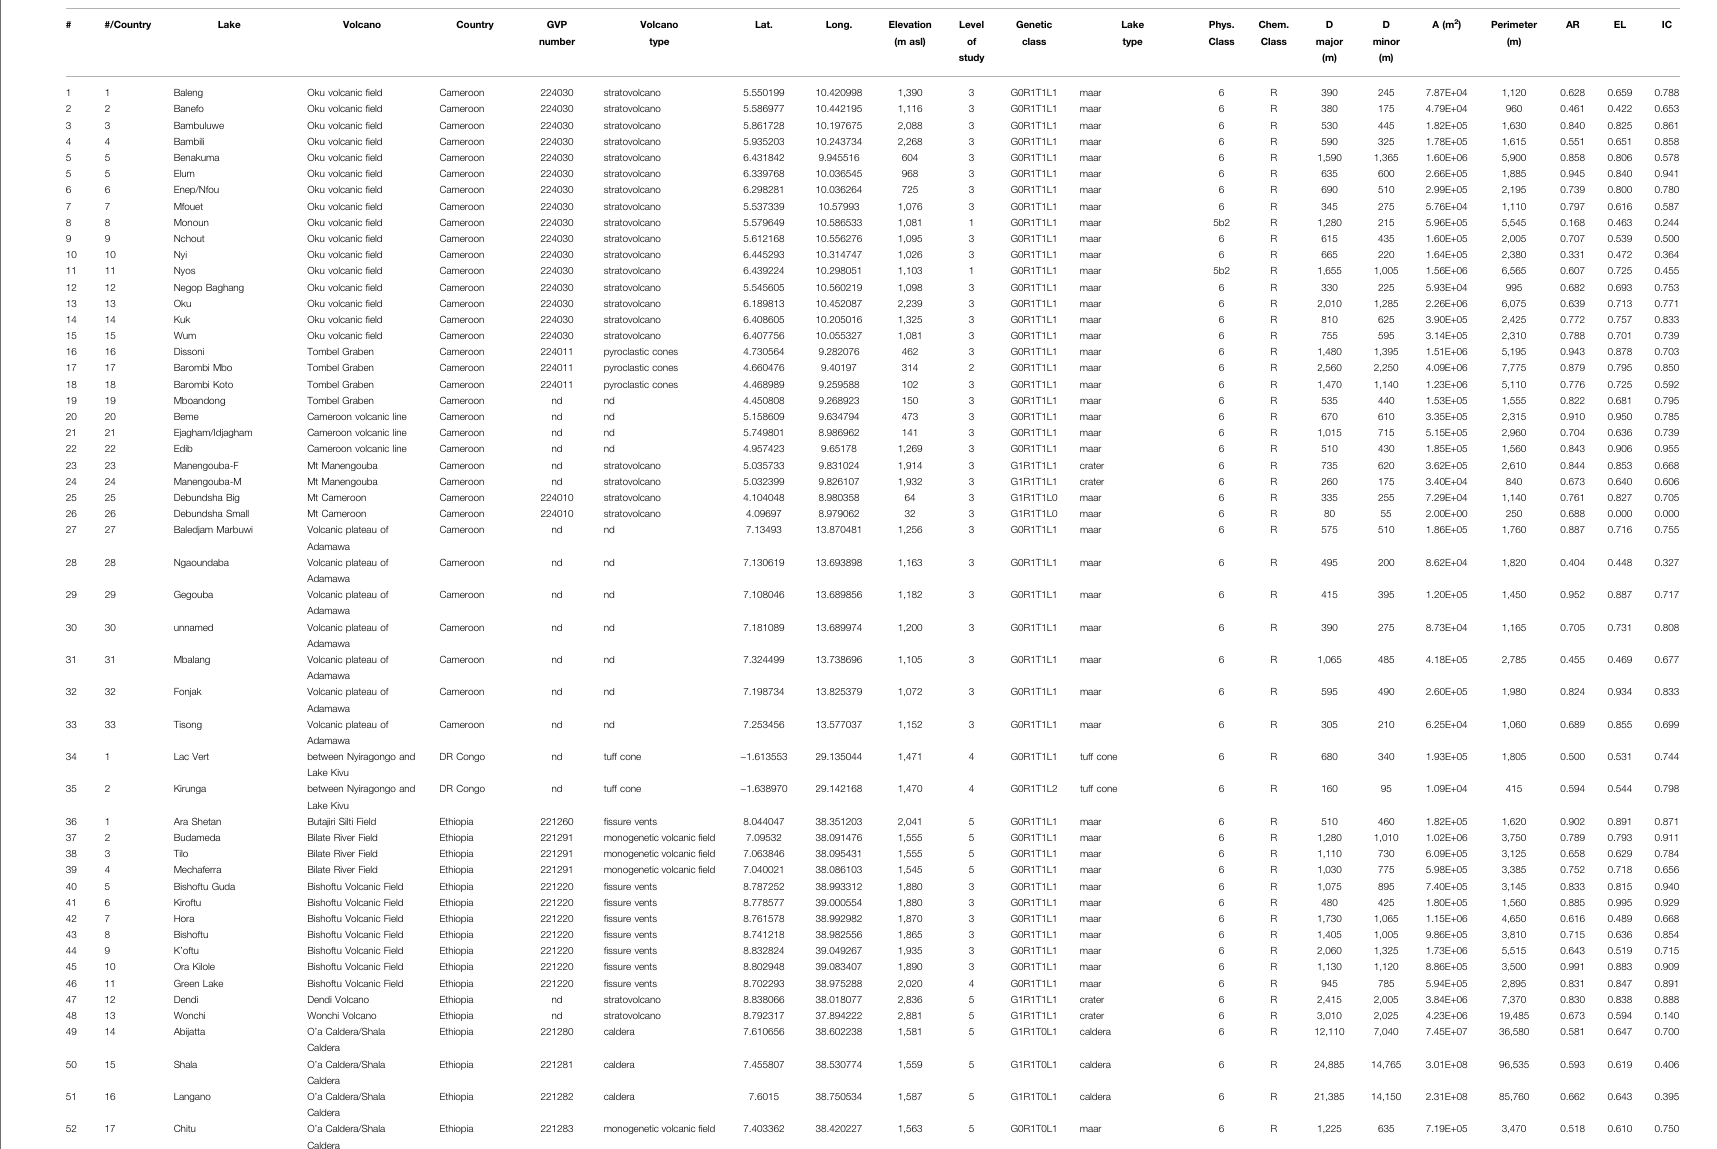
TABLE 1 | The VOLADA_Africa 2.0 database, mentioning the lake number (#), the number of lakes in the same country (#/country), the lake name, the volcano the depends on, the country, GVP number (Global Volcanism Program number https://volcano.si.edu/search_volcano.cfm), volcano type, the latitude and longitude (Lat. and Long. in decimal coordinates), the elevation above sea level (m a.s.l.), level of study (1 – 5, see text for details), genetic class ( see text for details), lake type, physical and chemical classi fi cation, length of major and minor lake axes (Dmajor and Dminor, respectively, in m), lake surface area (A, in m 2 ), lake perimeter (in meter), Aspect Ratio (AR, Eq. 1 ), Elongation (EL, Eq. 2 ), Isoperimetric Circularity (IC, Eq. 3